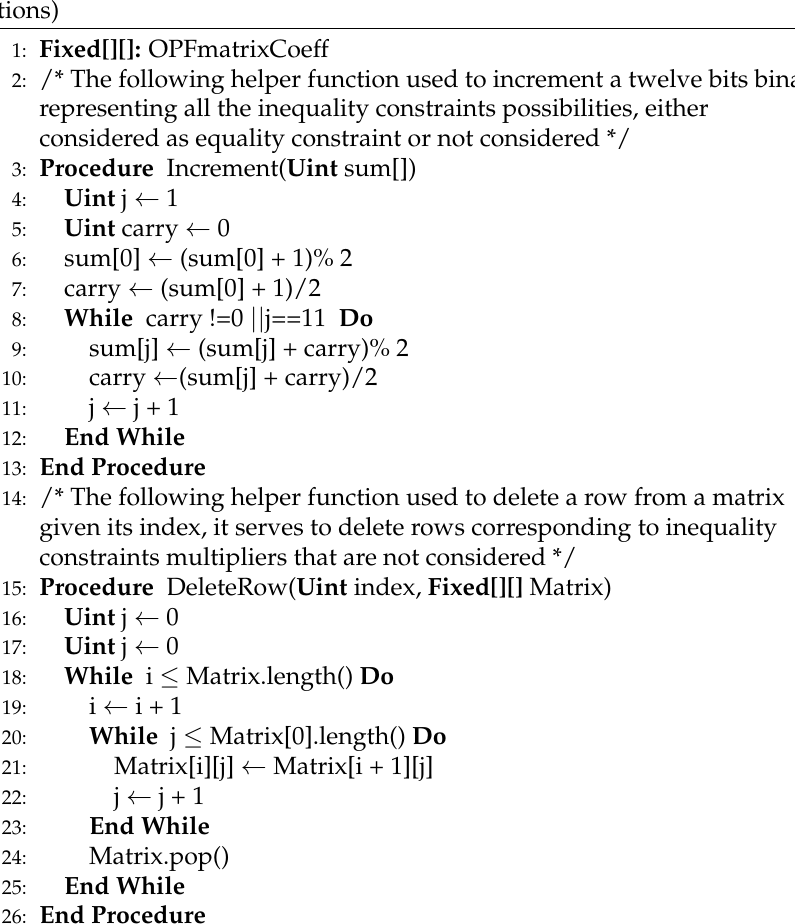
Algorithm 3 OPF Solver Smart contract: Update DC-OPF matrix coefficients (helper func-